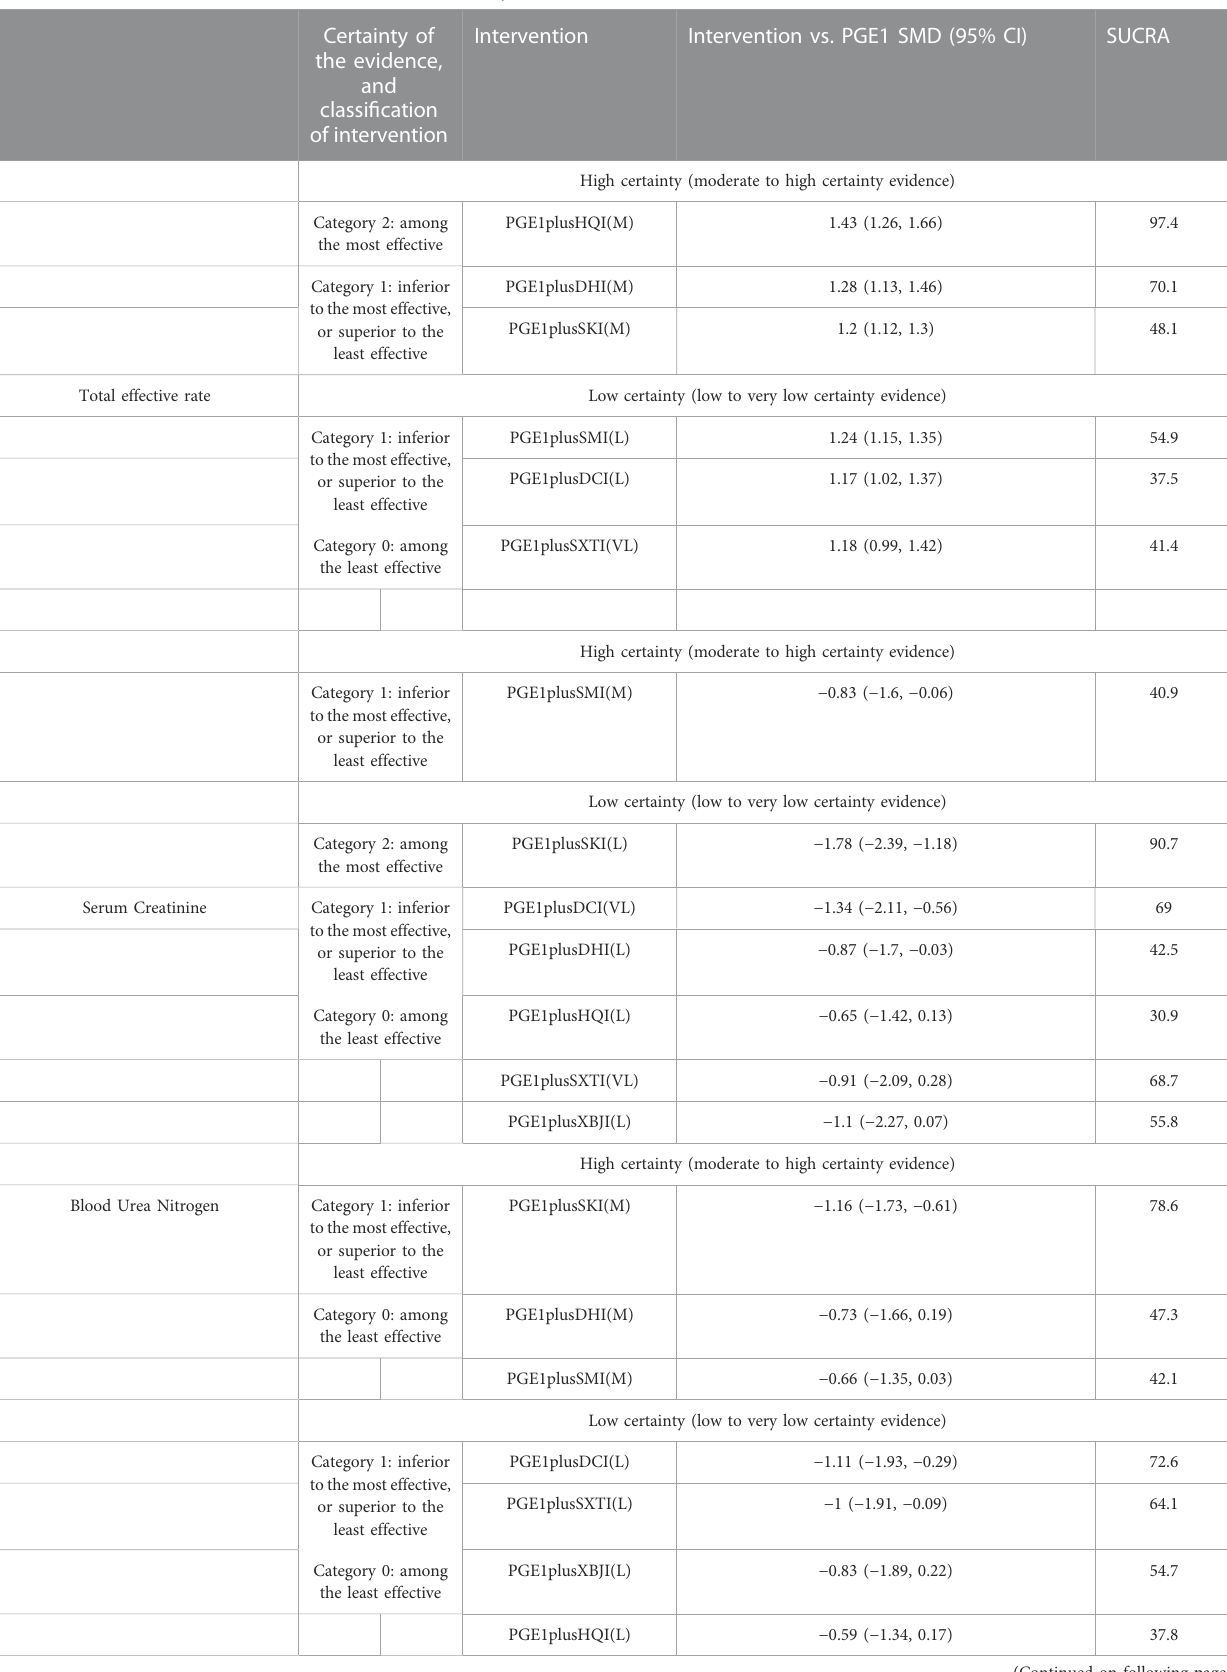
TABLE 5 Final classi fi cation of 7 interventions for Diabetic kidney